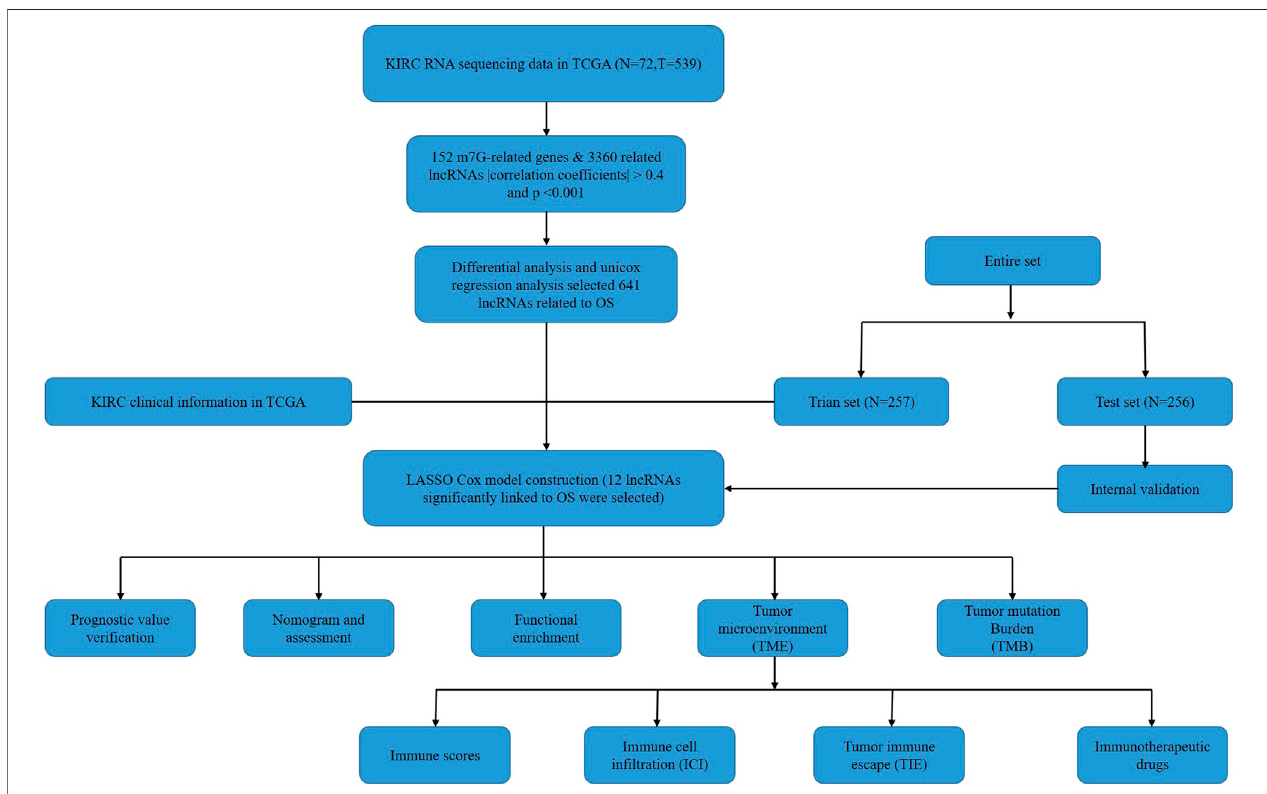
FIGURE 1 | Flow chart of the study.